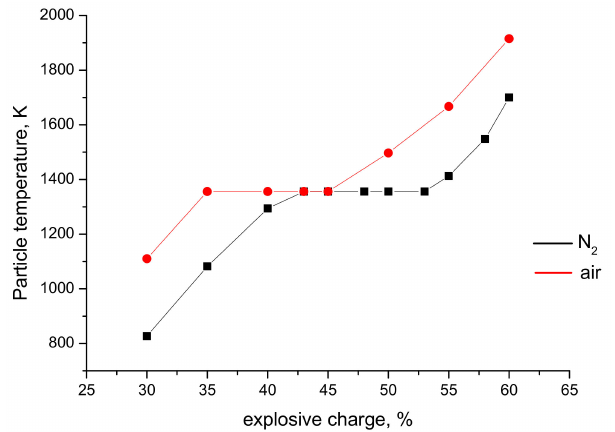
Figure 7. Calculated temperatures of copper particles 40 µ m in size exiting the barrel of the detonation gun sprayed with di ff erent explosive charges using nitrogen and air as carrier gases (barrel length 1000 mm, barrel diameter 20 mm, k = 1.1).